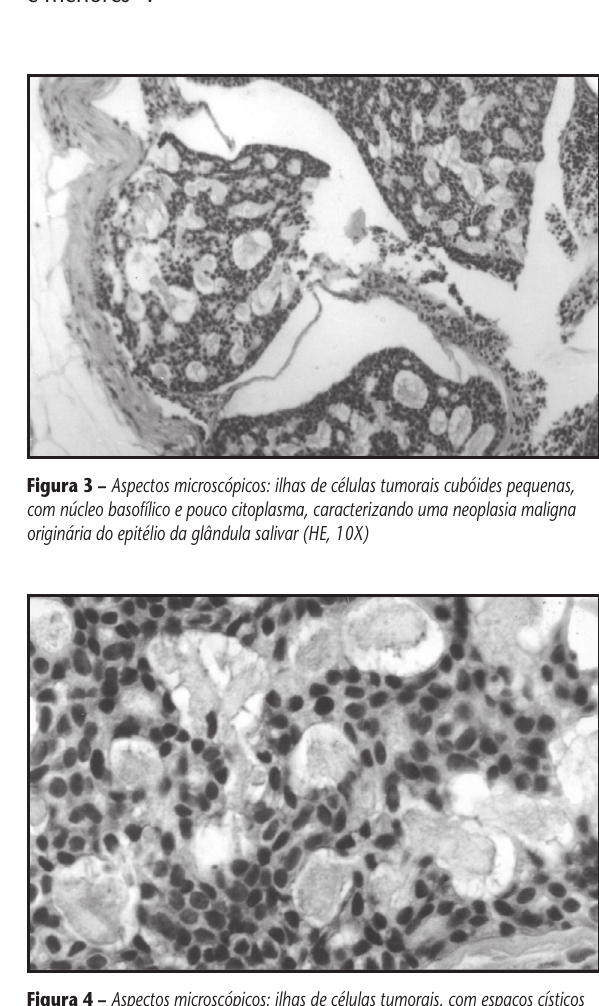
Figura 4 – Aspectos microscópicos: ilhas de células tumorais, com espaços císticos preenchidos com material hialino e mucóide (HE, 40X)